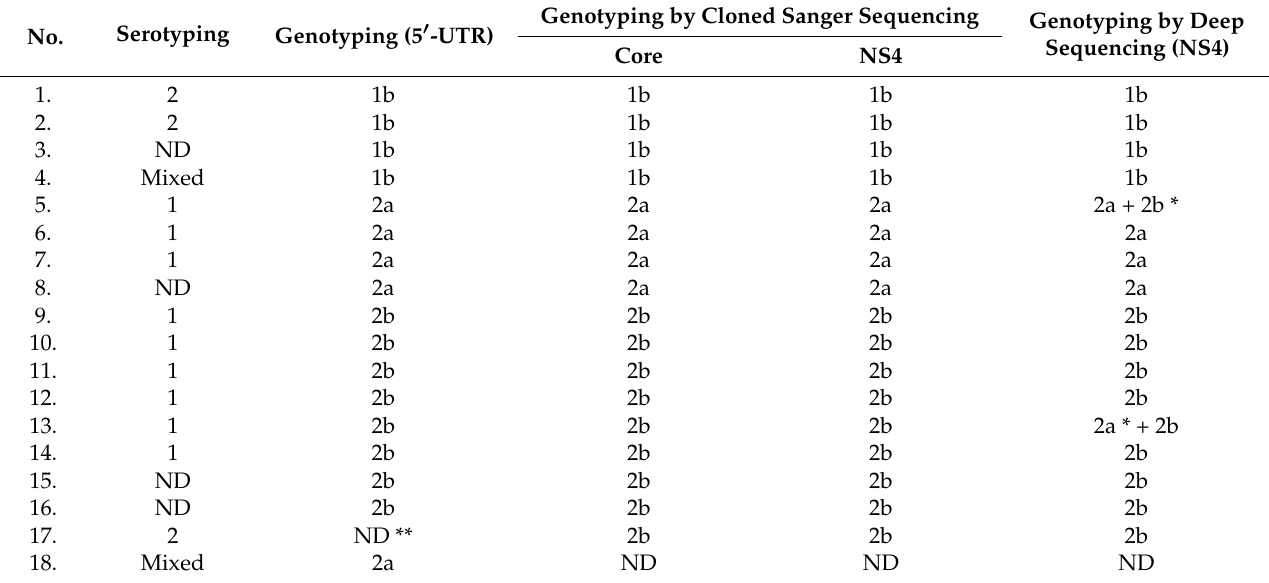
Table 2. Comparison between the results of serotyping, genotyping, Sanger sequencing and deep sequencing methods for discrepant samples. Genotyping by Cloned Sanger Sequencing Genotyping by Deep No. Serotyping Genotyping (5 (cid:48) -UTR) Sequencing (NS4)Core